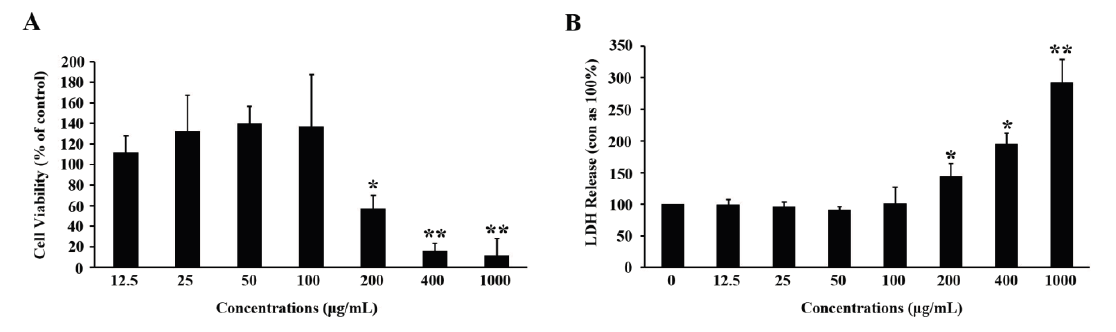
Figure 2. Cell toxicity of MTF on 3T3-L1 adipocytes. ( A ) Cells were incubated with various concentrations of MTF for 48 h. Cell toxicity was then measured in terms of cell viability; ( B ) The cell medium was collected 6 days after the incubation with MTF. LDH release was determined by its activity in the medium and corrected with the control. Data are mean ± SD from three independent experiments. * p < 0.05; ** p < 0.01 vs. control.